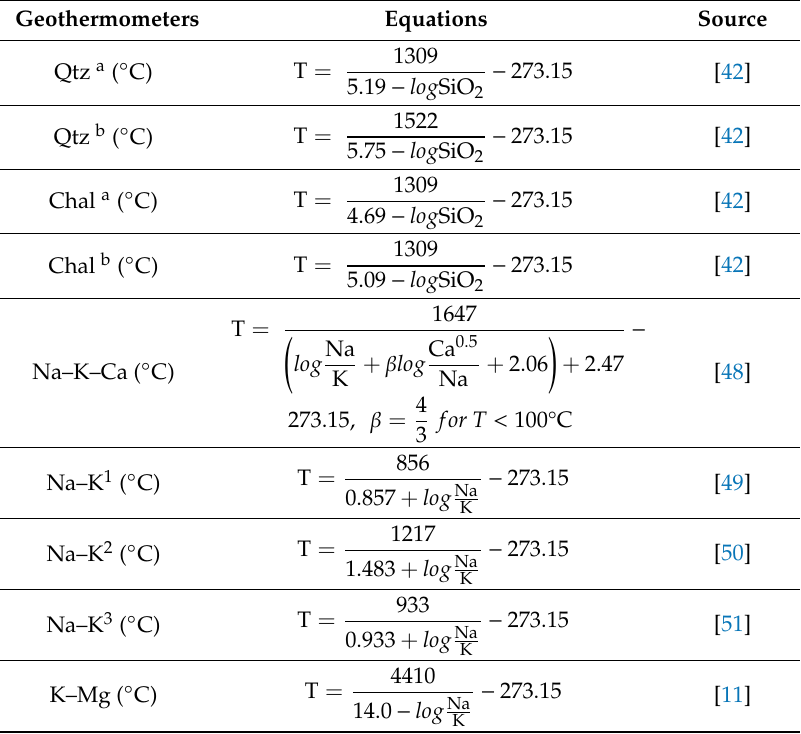
Table 4. Mathematical equations to estimate reservoir temperatures.